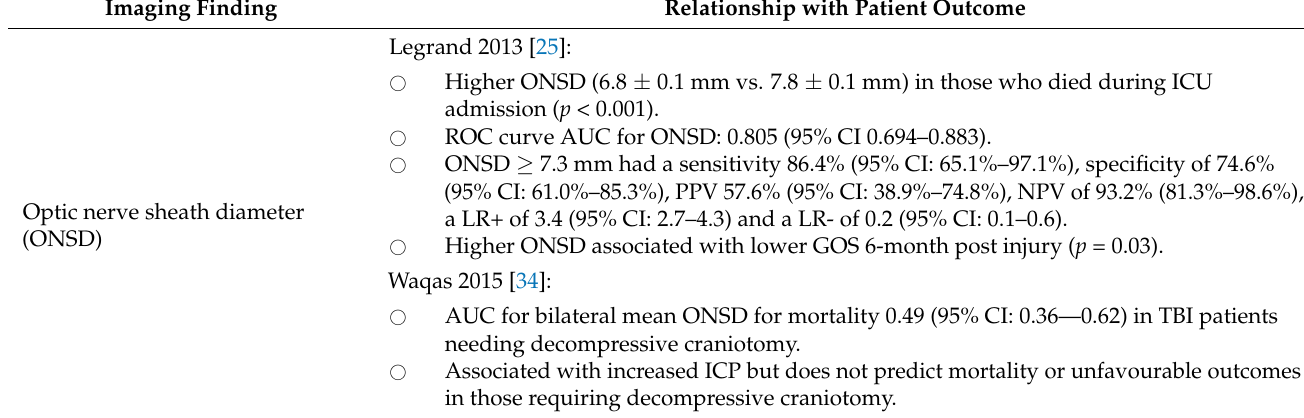
Table 2. Cont. Imaging Finding Relationship with Patient